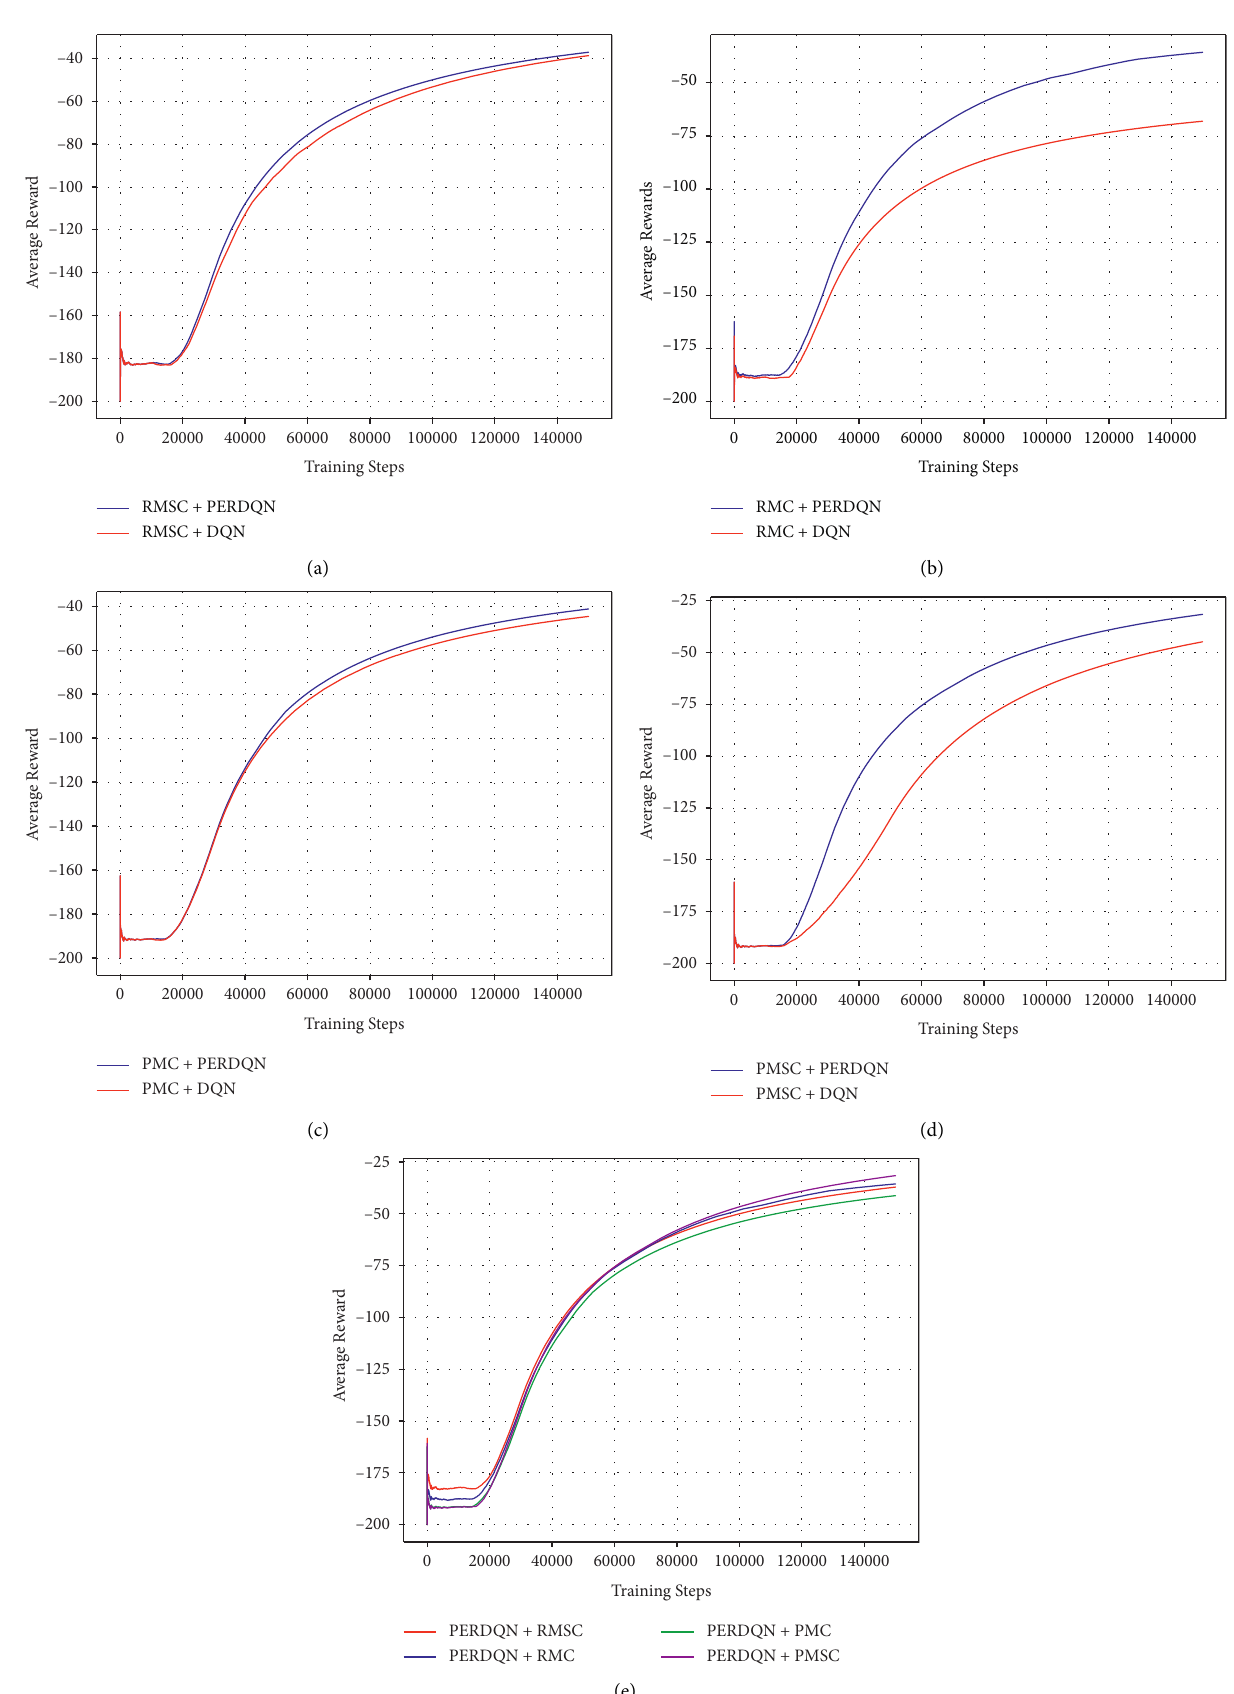
Figure 6: Average reward of PERDQN and DQN among training steps under different schemes in case 2. (a) Average reward under scheme 1. (b) Average reward under scheme 2. (c) Average reward under scheme 3. (d) Average reward under scheme 4. (e) Average reward comparison of PERDQN among four